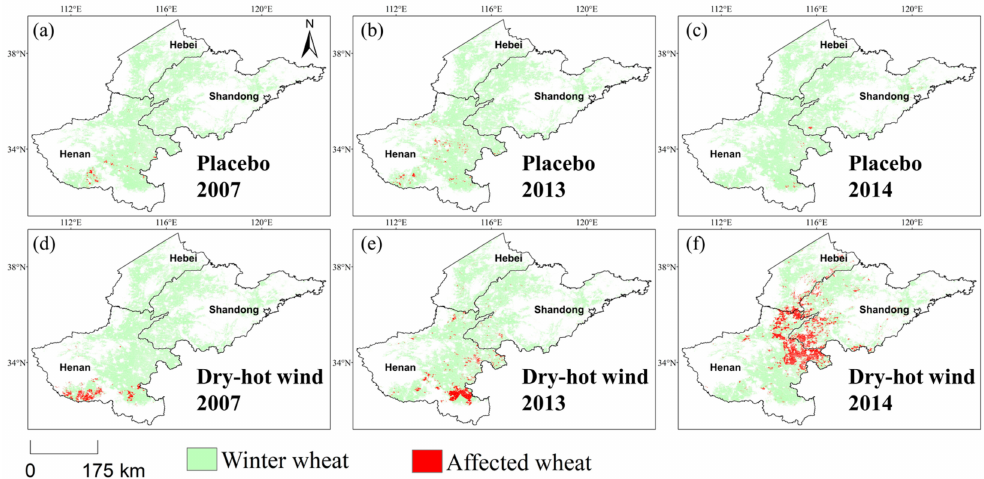
Figure 9. Results of the placebo trial of the three years used in this study. The first row is the placebo trial results ( a , b , c ) and the second row is the actual dry-hot wind monitoring results ( d , e , f